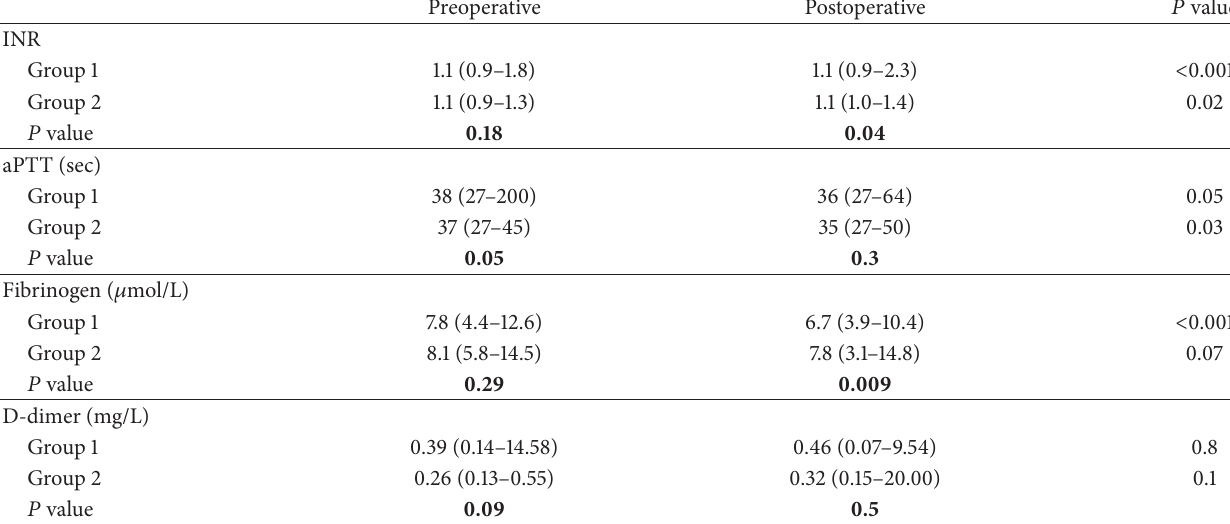
Table 3: Results of the different coagulation parameters in the two